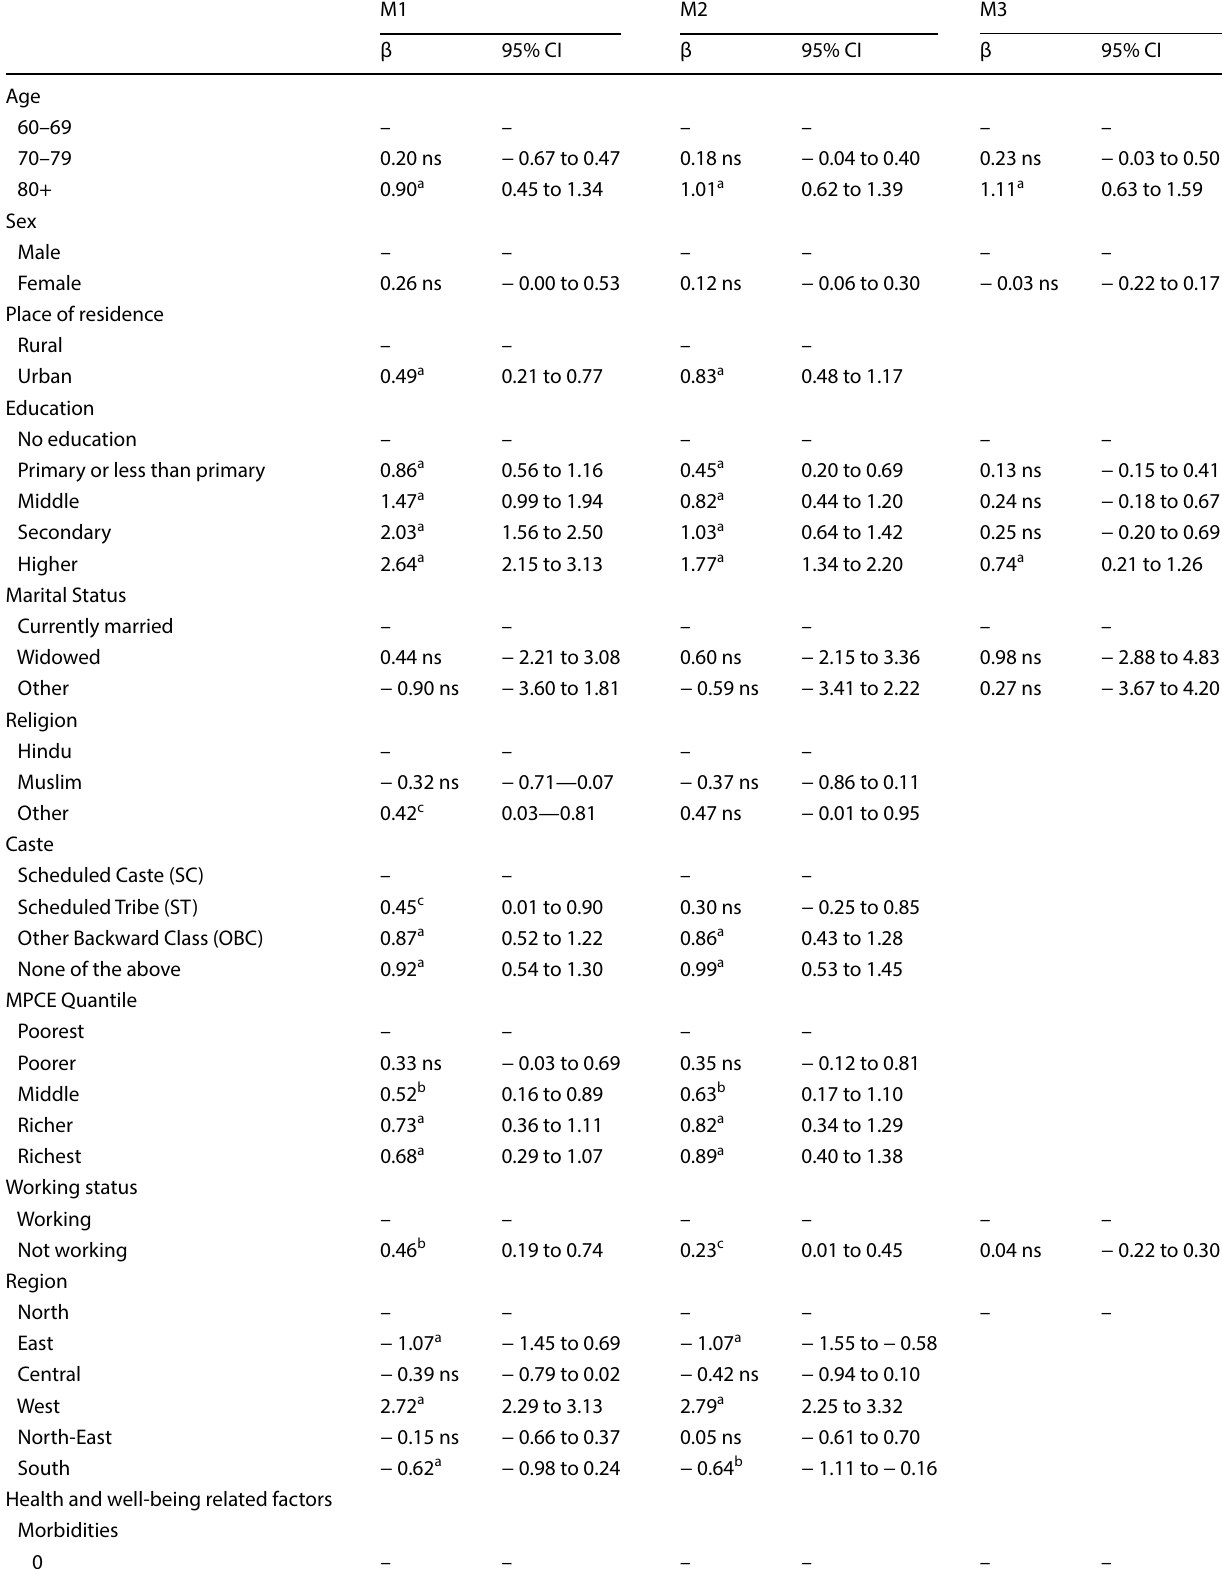
Table 2 Results of regression analyses assessing correlates of life satisfaction among Indian older adults